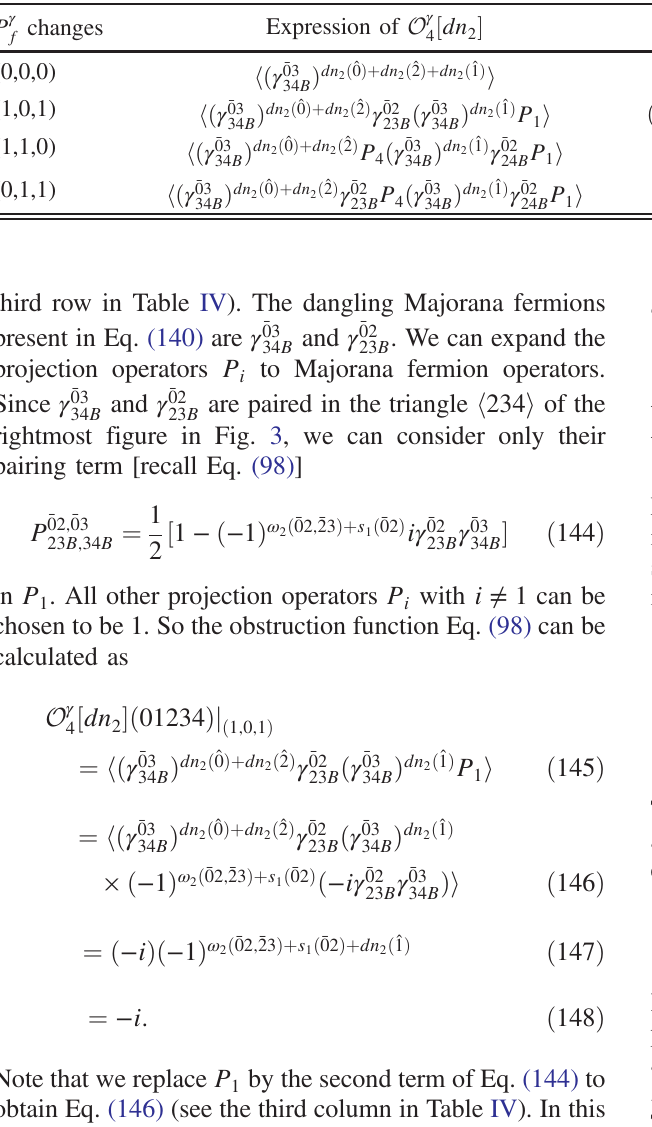
ˆ 0 ˆ 1 ˆ 2 ˆ 3 ˆ 4 Þ þ dn 2 ð Þ þ dn 2 ð Þ ; dn 2 ð Þ ; dn 2 ð Þ(cid:2) (mod 2). There are in total four